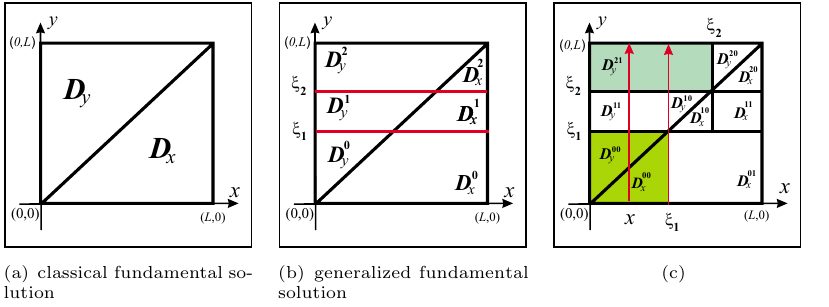
Figure 1. Domains of the Fundamental